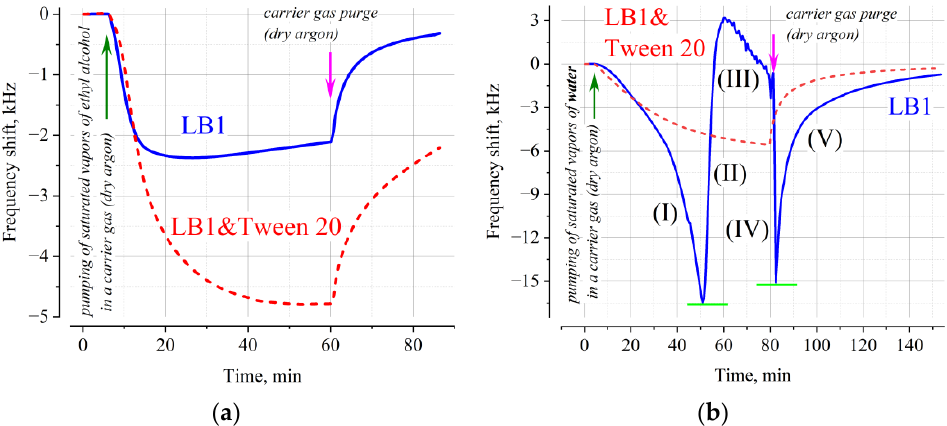
Figure 1. The typical responses of QCM transducers modified with LB1 and a mixture of LB1 with TWEEN ® 20 when saturated ethyl alcohol ( a ) or water ( b ) vapors are pumped over their surface.